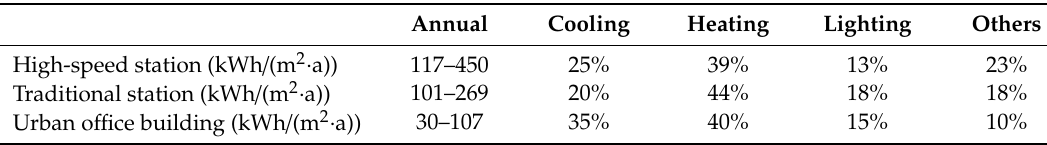
Table 2. Energy consumption data of di ff erent